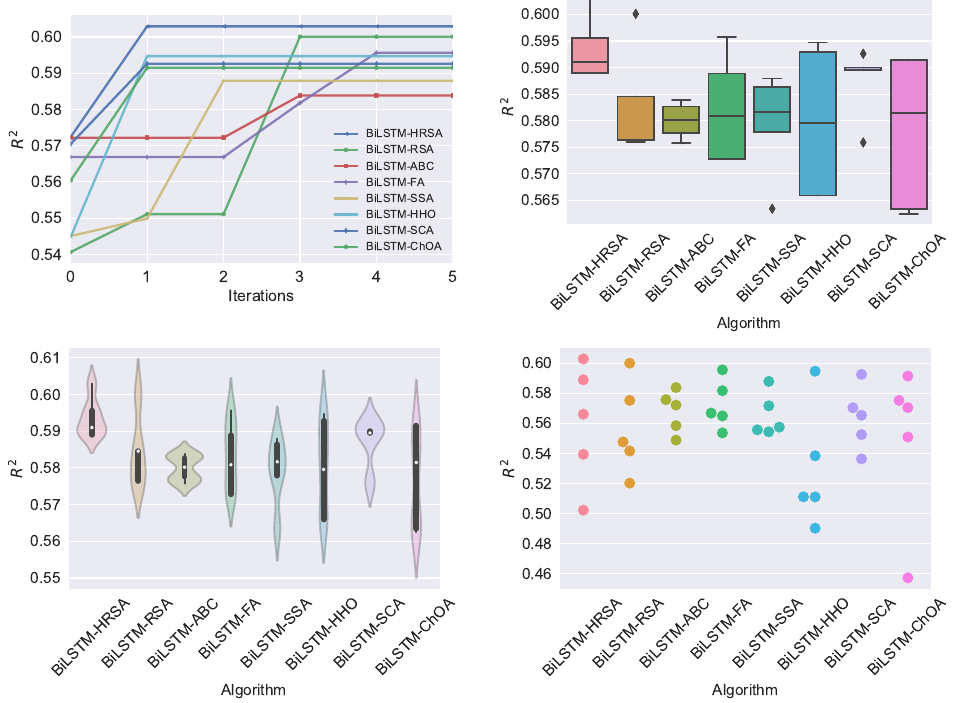
Figure 9. Visual BiLSTM simulations for each of 8 considered optimization methods with respect to the convergence, box plot, violin diagrams, and swarm diversity diagrams of the R 2 criterion.